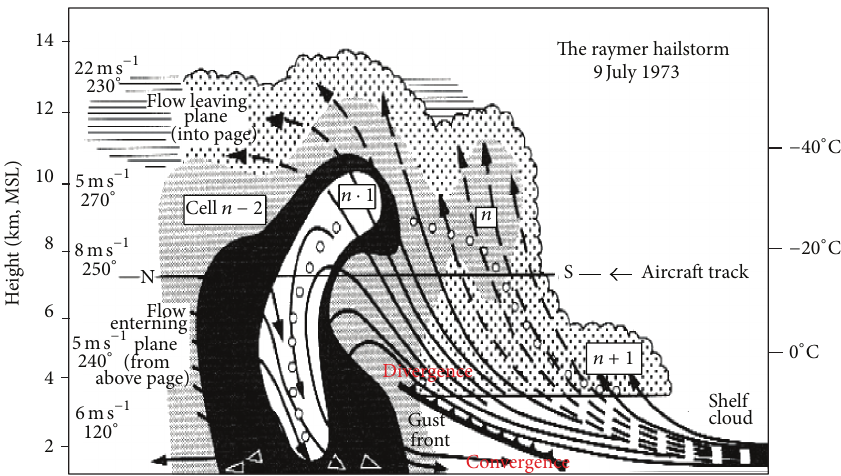
Figure 4: Schematic model of a supercell thunderstorm (from [4]). The solid and broken lines are streamlines of air flow relative to the moving system. Stippled, gray, and black shadings represent areas with low, medium, and high water content, respectively. The white area inside the black shading has the highest water content in the system. The thick line with triangular forms represents a gust front. The air in front of the gust front is warmer than the air behind the front and this leads to the development of updrafts in front of the front. The air behind the front is colder than that in front of the front due to evaporative cooling, which develops downdrafts. These updrafts and downdrafts are connected to each other to form a circulation through divergence of air (centering in the area with “Divergence”) from the front part of the gust front to its back part and convergence of air (centering in the area with “Convergence”) from the back part of the gust front to its front